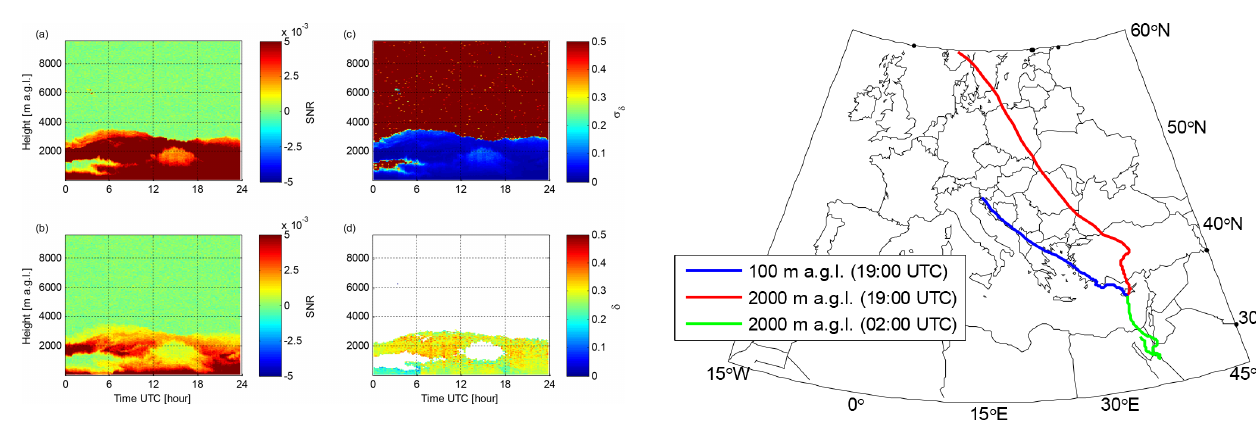
Figure 9. Back trajectories of 96h arriving at Limassol on 27 April. Back trajectories arriving at 19:00 and 02:00UTC are included.